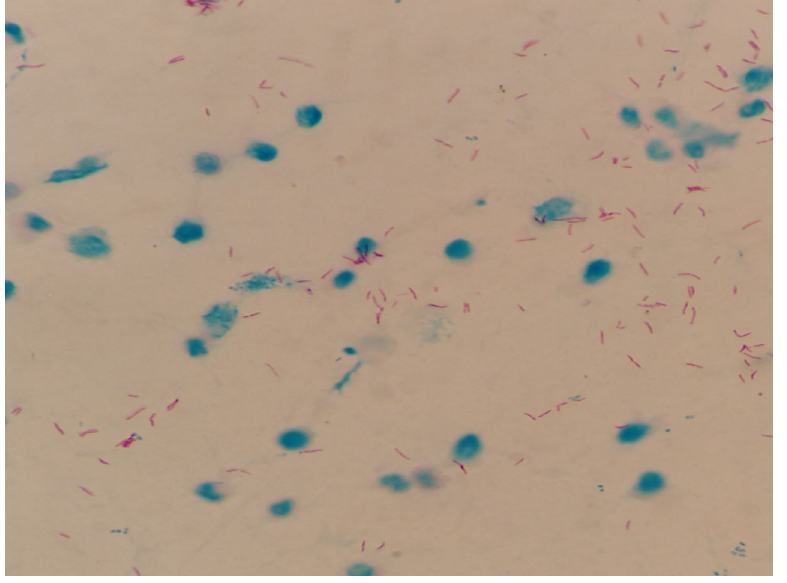
Fig 7. Cut microscope image. 2513 � 2073